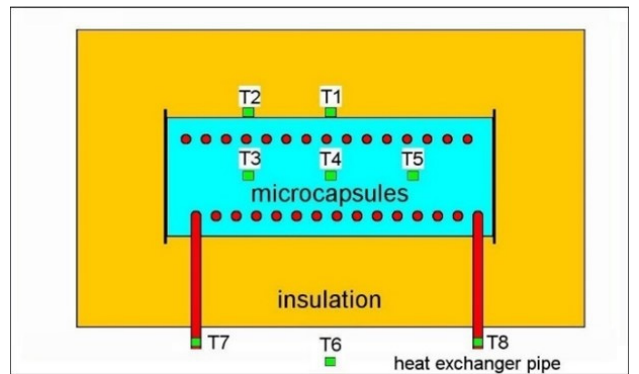
Figure 1. Schematic drawing of the prototype tank (median longitudinal section—viewed from the top): light blue—microcapsules, green—T1 to T8 thermocouples, yellow—insulation, red—heat exchanger. T6 is the room temperature thermocouple.